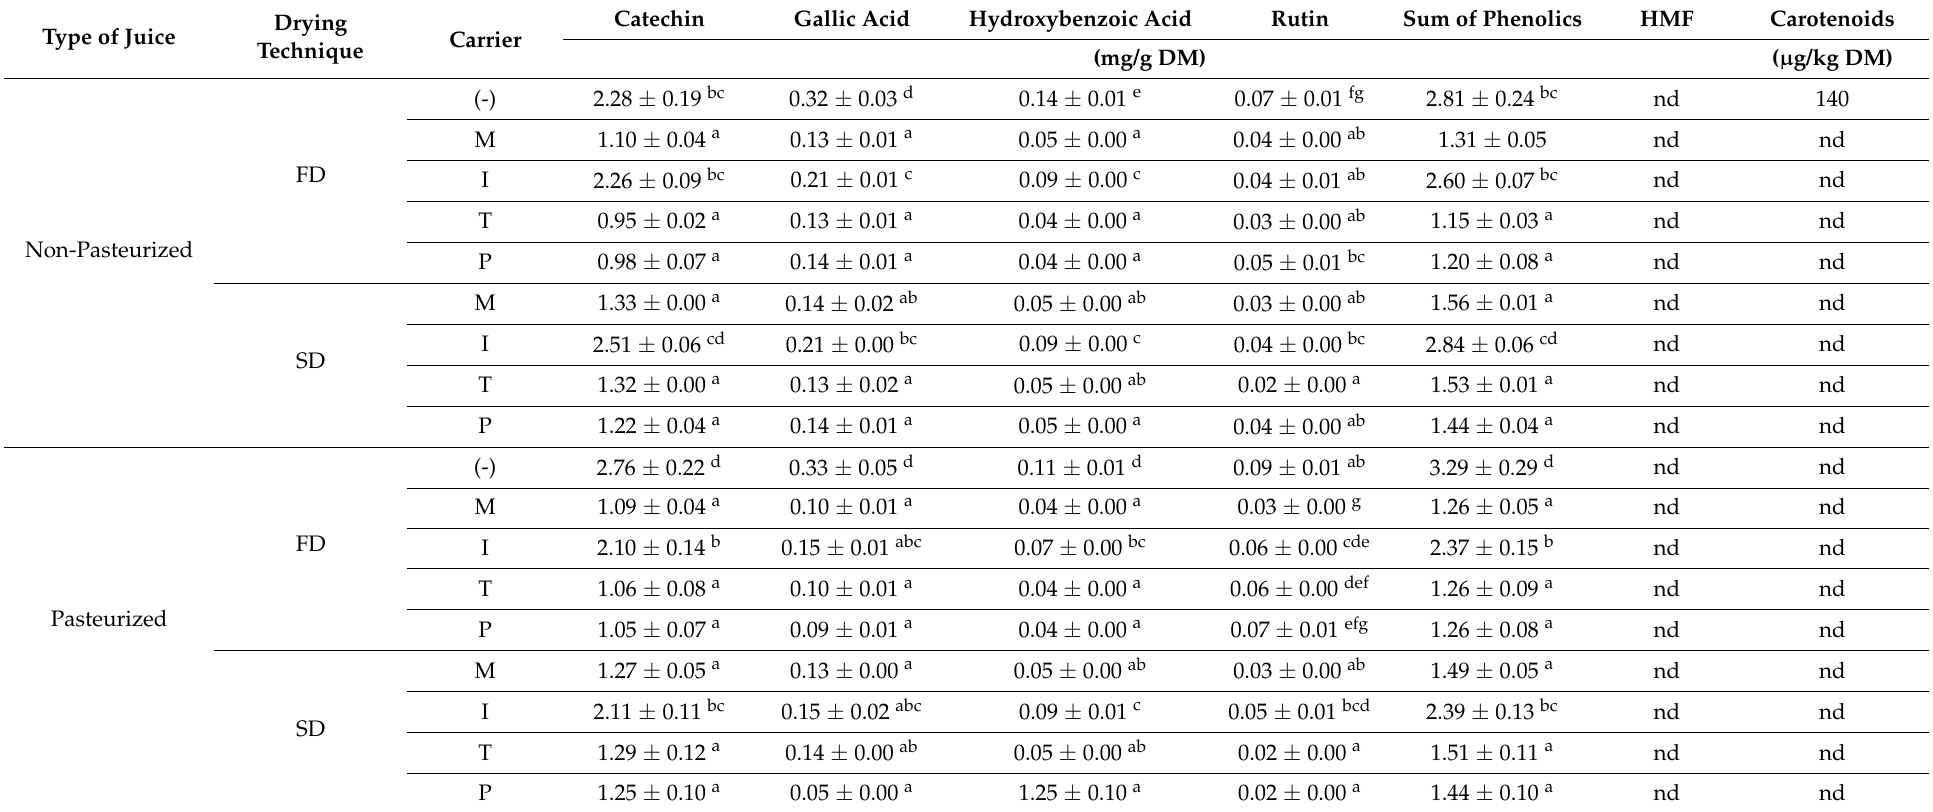
Table 3. The content of identified phenolics (mg/g DM), hydroxymethyl- L -furfural (HMF) (mg/g DM) and carotenoids ( µ g/kg DM) in rosehip juice powders obtained after freeze- and spray drying ( n = 2; average ± standard deviation). (-)—no carrier addition, M–maltodextrin, I–inulin, T–trehalose, P–palatinose, differences (HSD Tukey test; p ≤